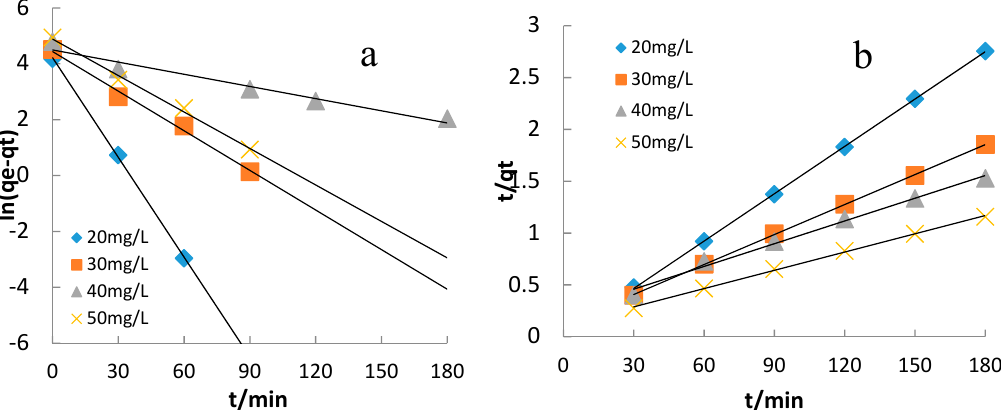
Figure 9. Pseudo-first-order kineticcurve ( a ) and pseudo-second-order kinetic curve ( b ) of photocatalytic degradation of MB by 1.4% CuO/bentonite (400 ◦ C) composite at different MB concentrations.